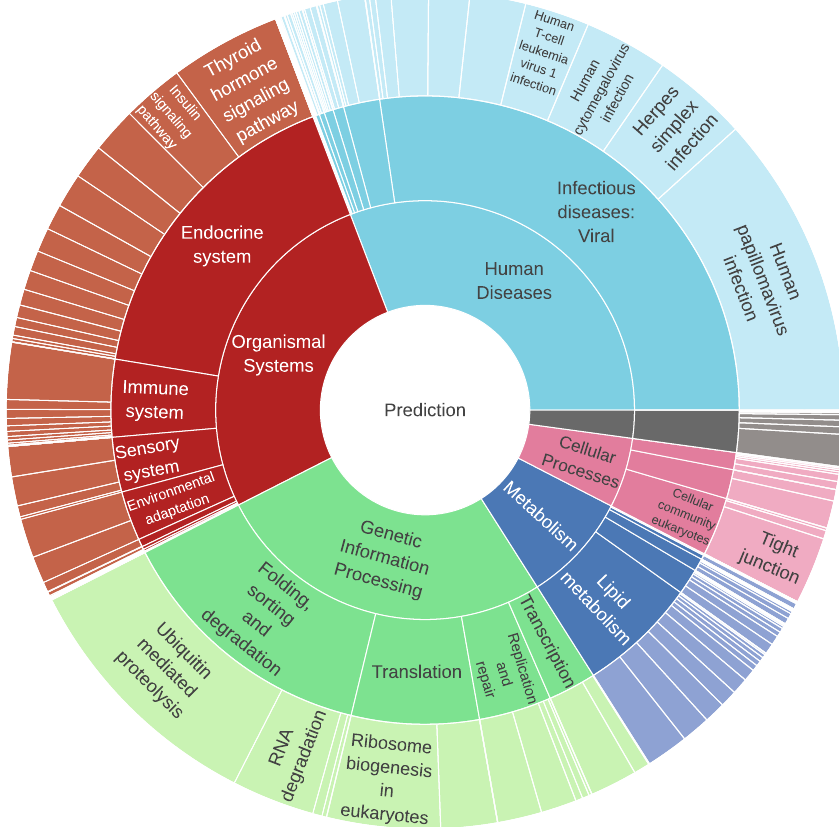
Fig. 3 Sunburst plot of the important KEGG pathways for predicting schizophrenia. A neural network with layers based on KEGG pathway information was trained to predict schizophrenia. The relative importance was calculated for each pathway using the learned weights of this neural network. The sunburst plot is read from the center, which shows the output node with the prediction of the neural network. The inner ring represents the last layer with the highest-level pathways, followed by the mid-level pathways, and fi nally the lowest-level pathways. The gene and SNP layer are omitted for